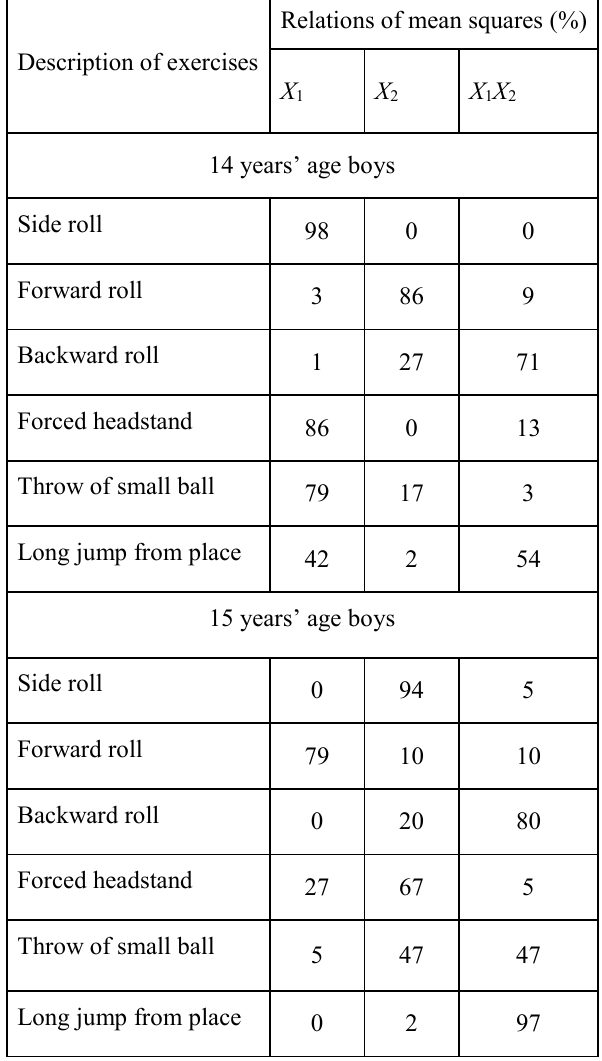
Results of dispersion analysis for FFE 2 2 , concerning influence of quantity of repetitions (Х 1 ) and rest intervals (Х 2 ) on 14-15 years’ age boys’ training to physical exercises Relations of mean squares Description of exercises